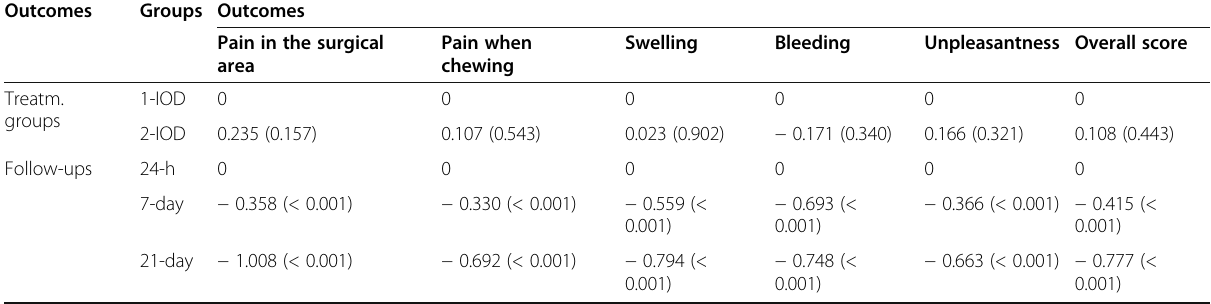
Table 3 Regression estimates for the symptoms outcomes according to the treatment groups and follow-up periods. Data are regression coefficients (and p -values)